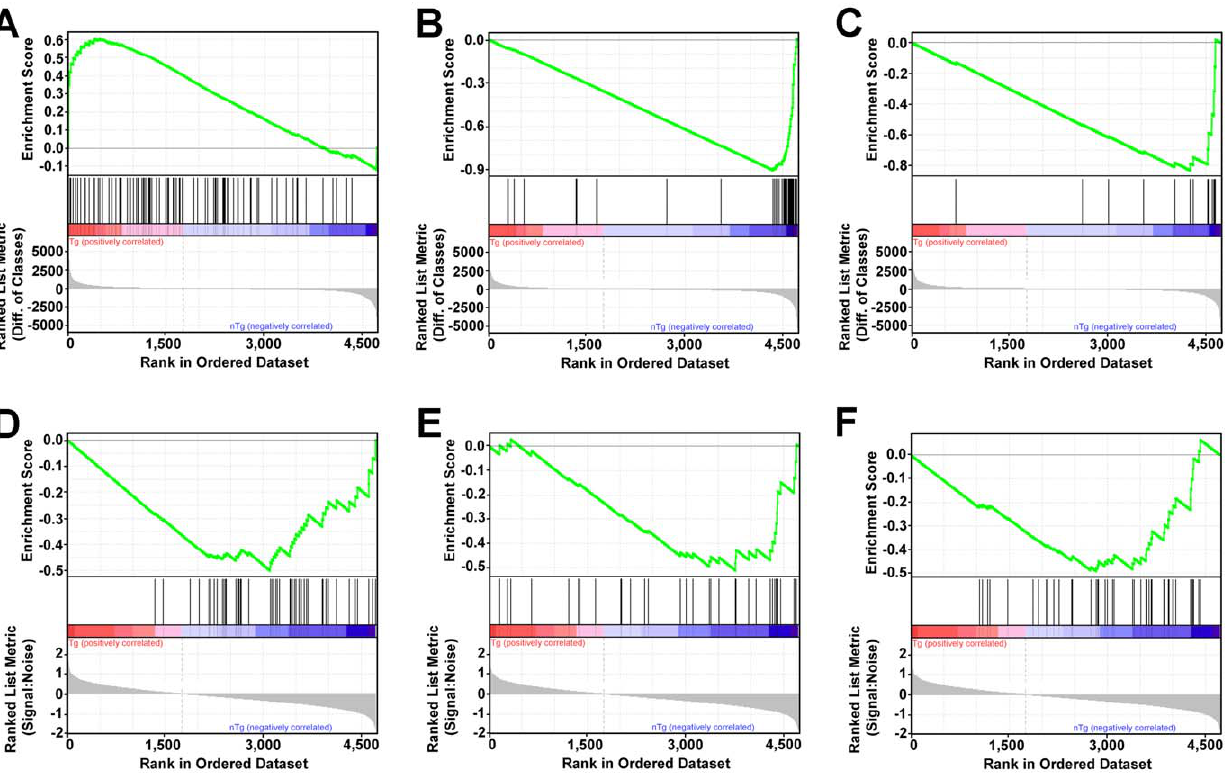
Figure 4. GSEA Enrichment Plots of GO Molecular Functions and KEGG Canonical Pathways With the Largest Normalized Enrichment Scores. (A) Receptor Activity (GO0004872), (B) Structural Constituent of Ribosome (GO0003735), (C) Hydrogen Ion Transporting ATPase Activity (GO0046961), (D) Ribosome, (E) Oxidative Phosphorylation, (F) Pyrimidine Metabolism. Top portions of the plots show the running enrichment score for the gene set as the analysis ‘‘walks down’’ the ranked list. Middle portions of the plots shows where members, indicated by vertical black lines, of the gene set appear in the ranked list of genes. Bottom portions of the plots show the value of the ranking metric as one progresses down the list of ranked genes.